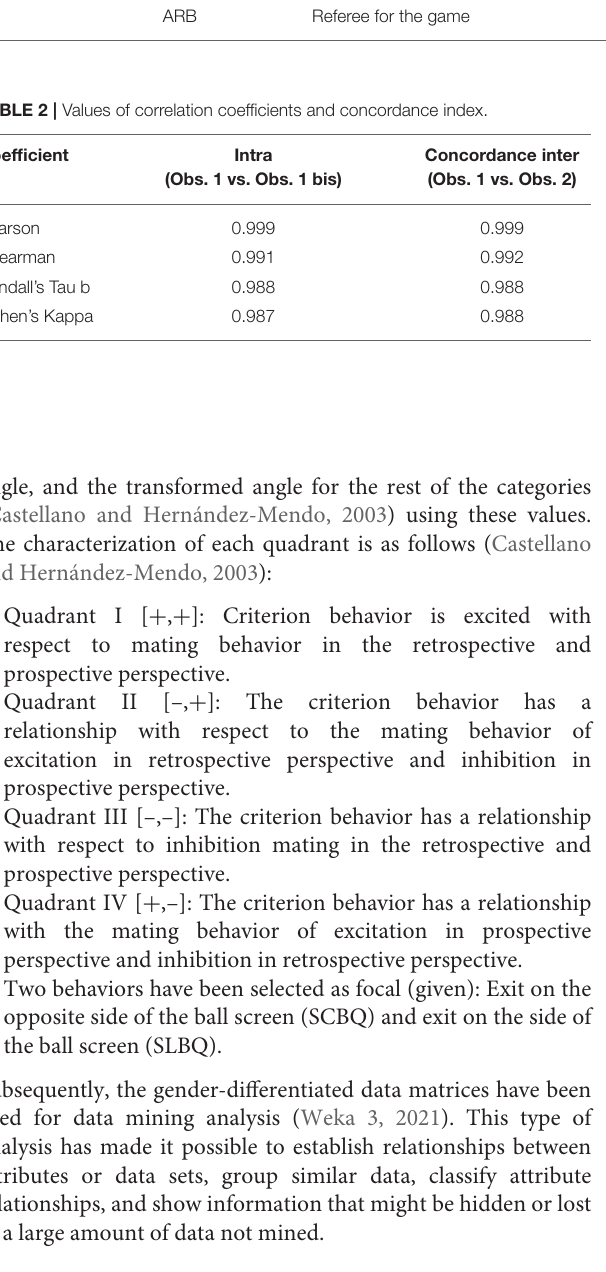
Referee for the game